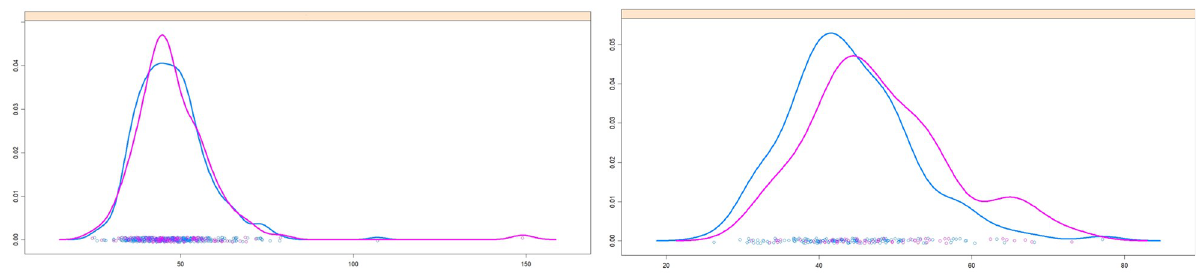
Fig 6. Probability density functions for pCO 2 -records of affected (pink curves) and control (blue curves) patients. Left panel: Extremely preterm infants. Right panel: Very preterm infants.